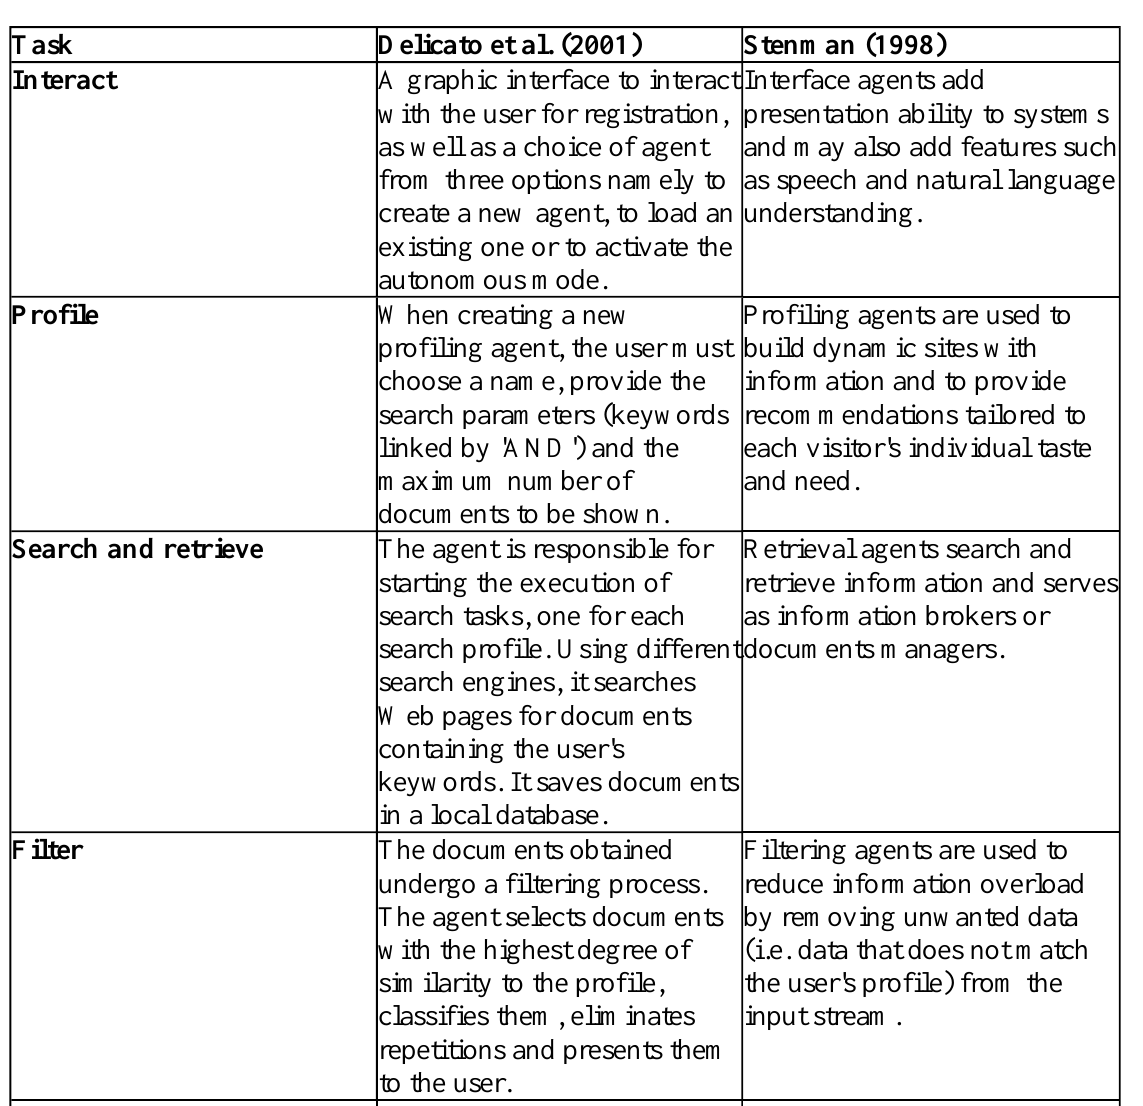
Table 2 Specific abilities of an intelligent agent in proving Web information to a